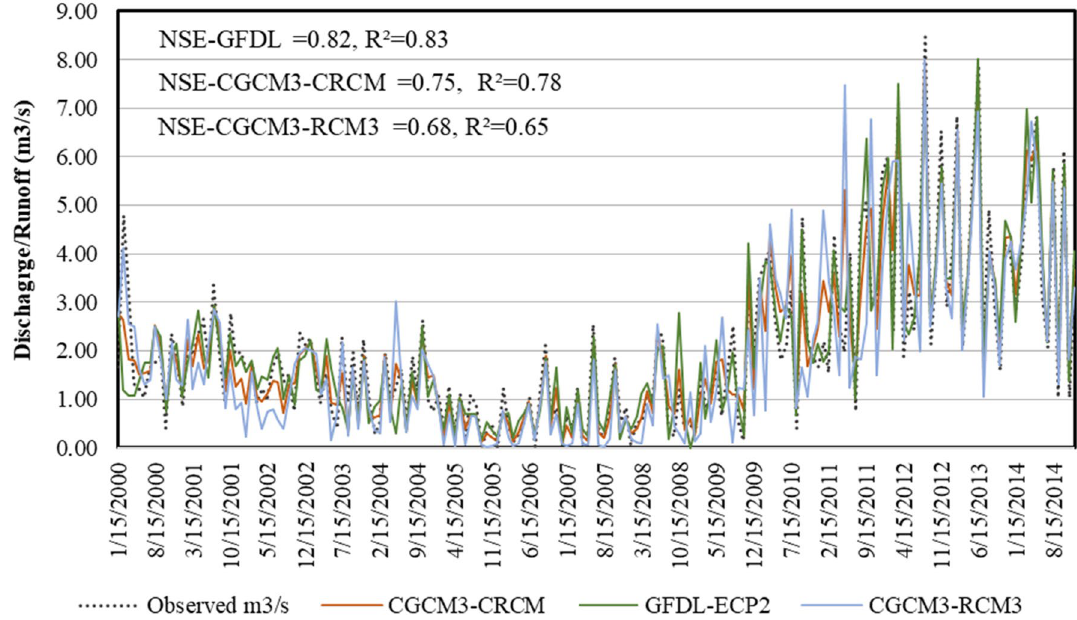
Figure 6. Comparison of modeled discharge with baseline (2000–2014).